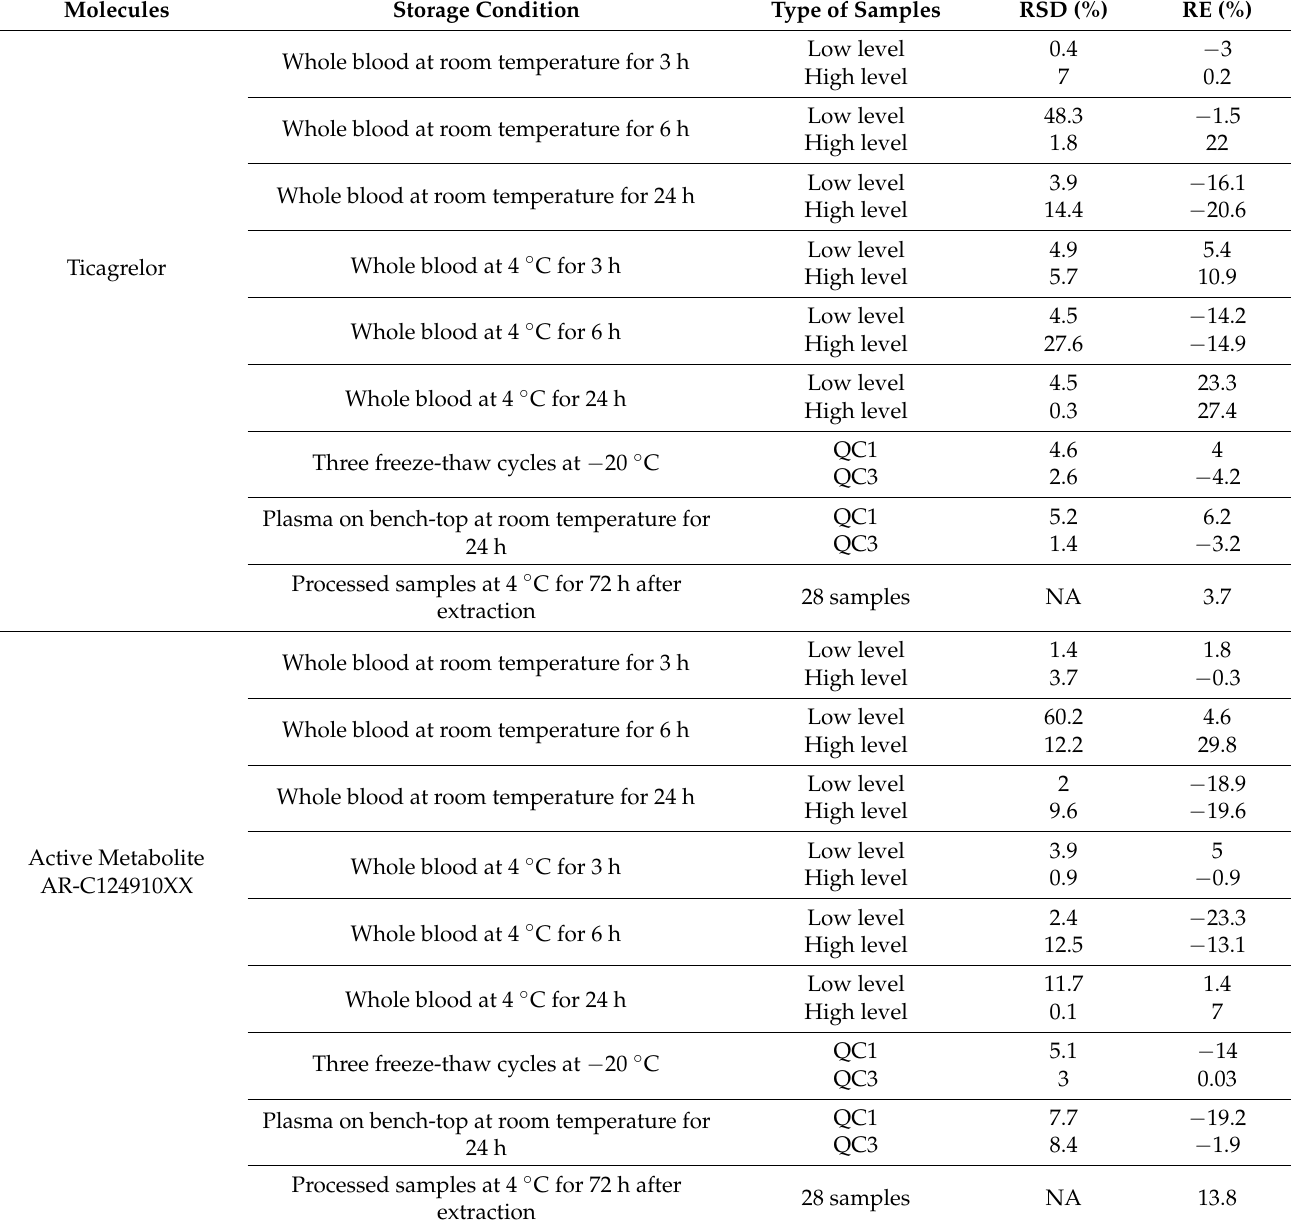
Table 2. Stability of ticagrelor and its metabolite